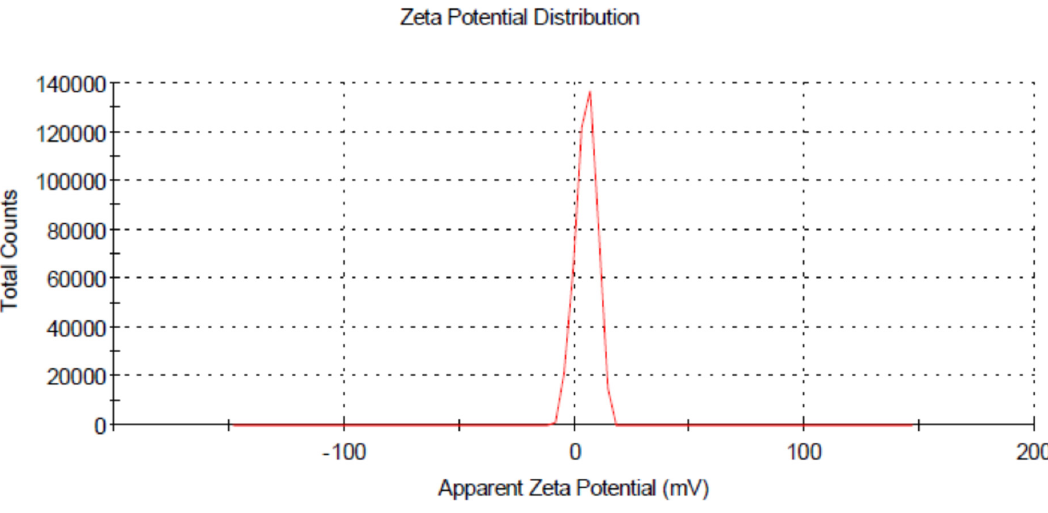
Figure 6. Zeta potential for salicylic acid nanoparticles.